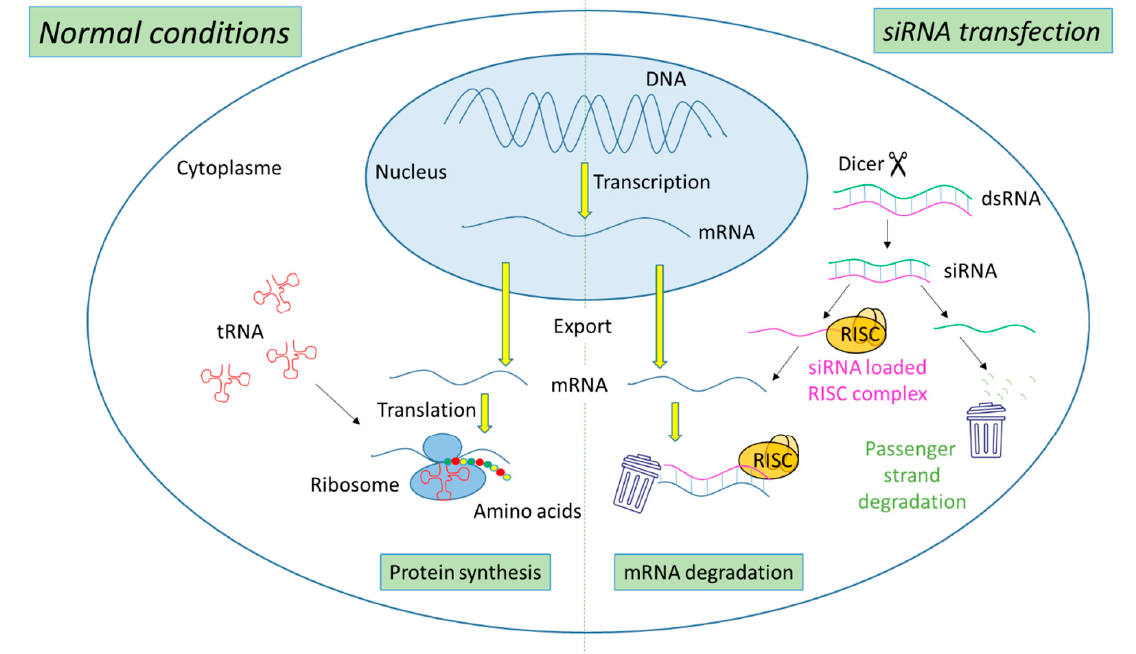
Figure 1. Representation of gene expression leading to protein synthesis in “normal conditions” in comparison with mechanism leading to mRNA degradation before protein synthesis in the presence of siRNA.